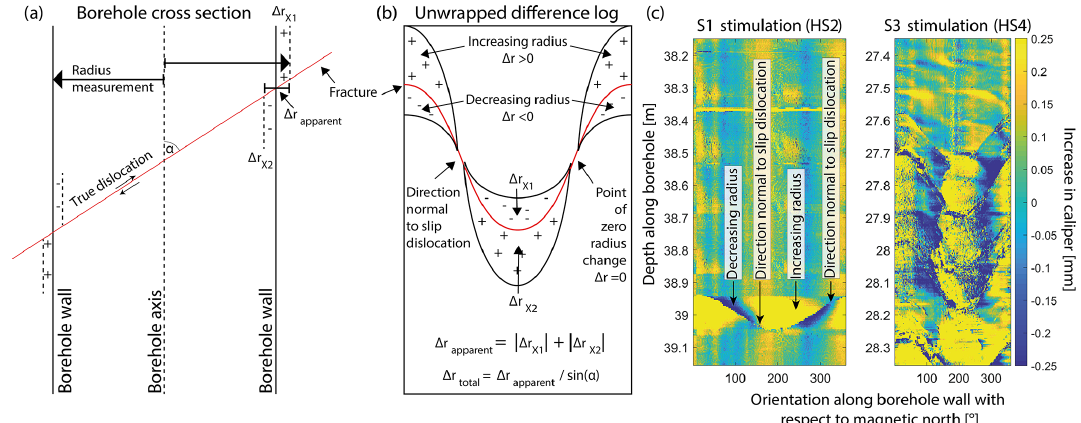
Figure 5. (a) Illustration of the travel time (i.e., radius) measurement of an ATV log across a sheared fracture. (b) Observation of slip displacement direction and apparent magnitude estimate visualized in the unwrapped difference log. (c) Difference logs for HS2 and HS4 experiments. A clear trace of a reactivated fracture is visible in the HS2 log, whereas a diffuse trace with potential borehole wall damage is shown in the HS4 log.